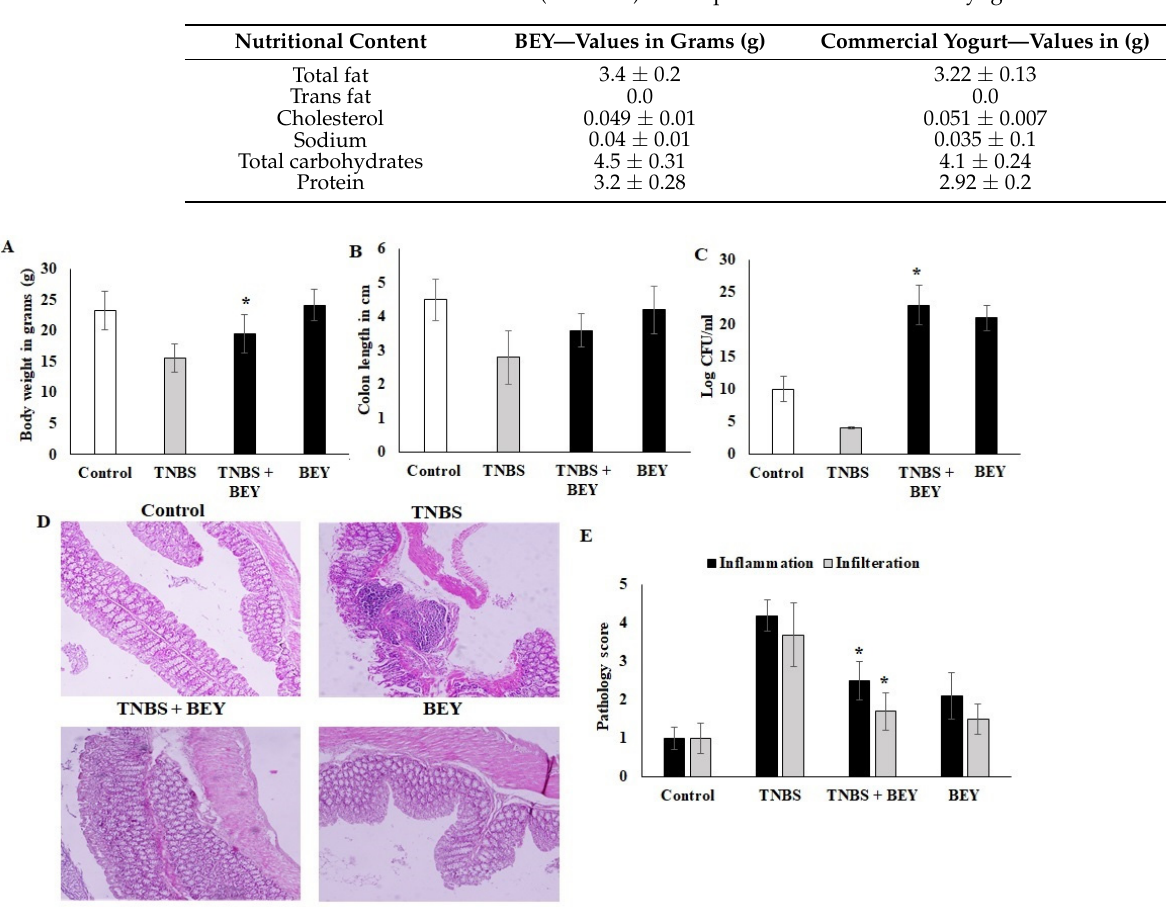
Figure 2. BEY alleviated TNBS-induced colitis in C57Bl6j mice. TNBS induction was made at 0 and 4 days of induced mice; BA 10 8 /mL was administered as oral gavage at alternative days from 0 to